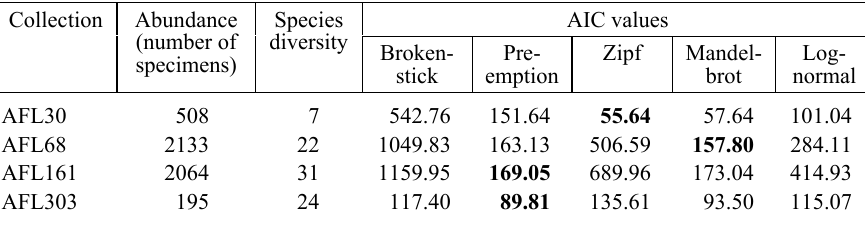
Table 1. Abundance, diversity, and AIC of the five models for the four collections; numbers in bold represent the model best fitted for the species-abundance